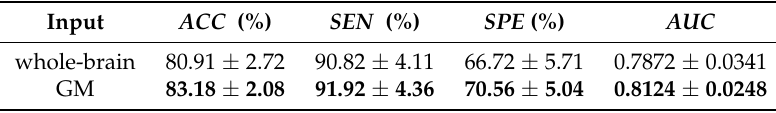
Table 14. Classification performance of models with different inputs for T2